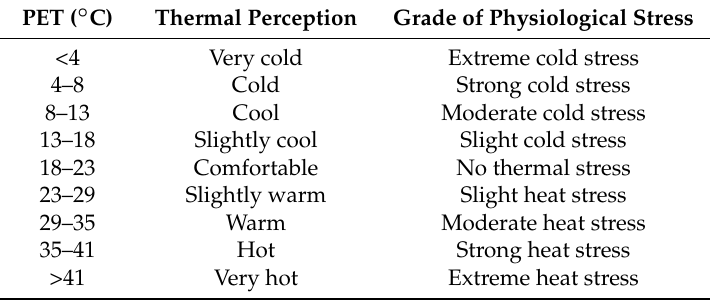
Table 3. Ranges of physiologically equivalent temperature (PET in ◦ C) for different grades of thermal perception by humans according to Matzarakis and Mayer [32] with internal heat production: 80 W and heat transfer resistance of the clothing: 0.9 clo. PET ( ◦ C) Thermal Perception Grade of Physiological Stress <4 Very cold Extreme cold